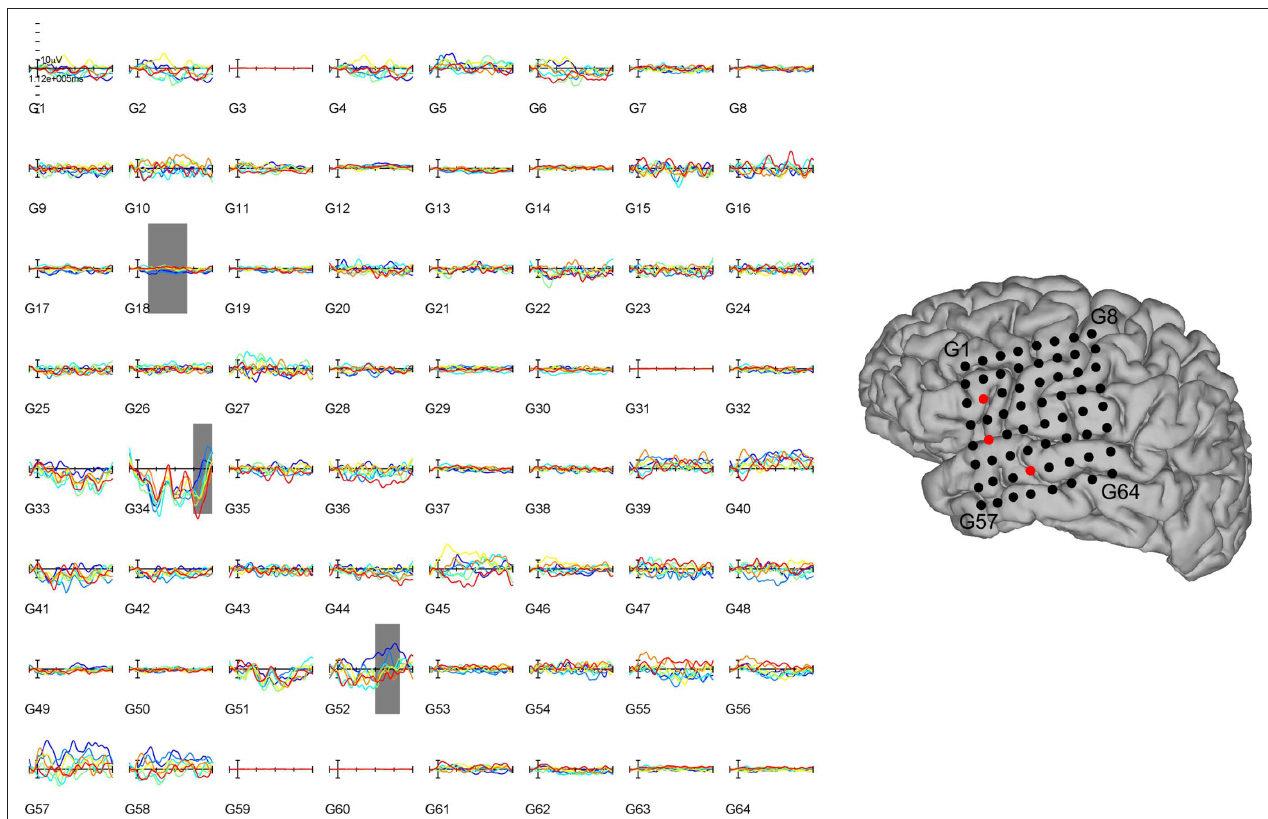
Figure A4 | evoked potentials from S7 across the seven ∆ F conditions used for this